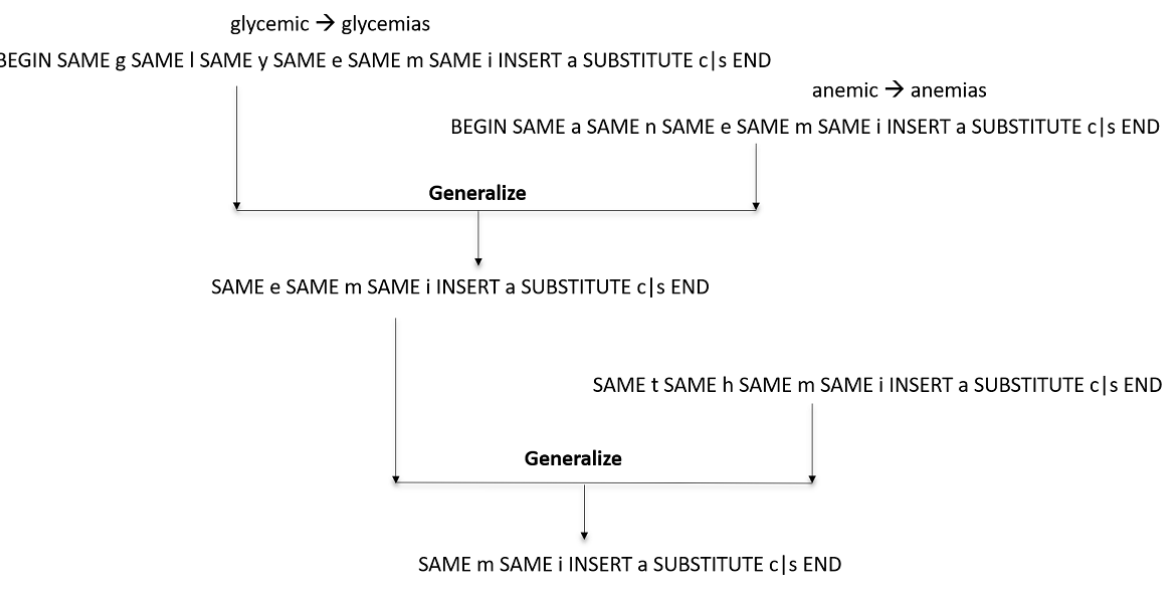
Figure 2. An illustrative example of how the method generalizes edit patterns by finding the longest contiguous common pattern that includes all the edit operations. In this example, it learns the edit pattern to convert clinical terms ending with “mic” to